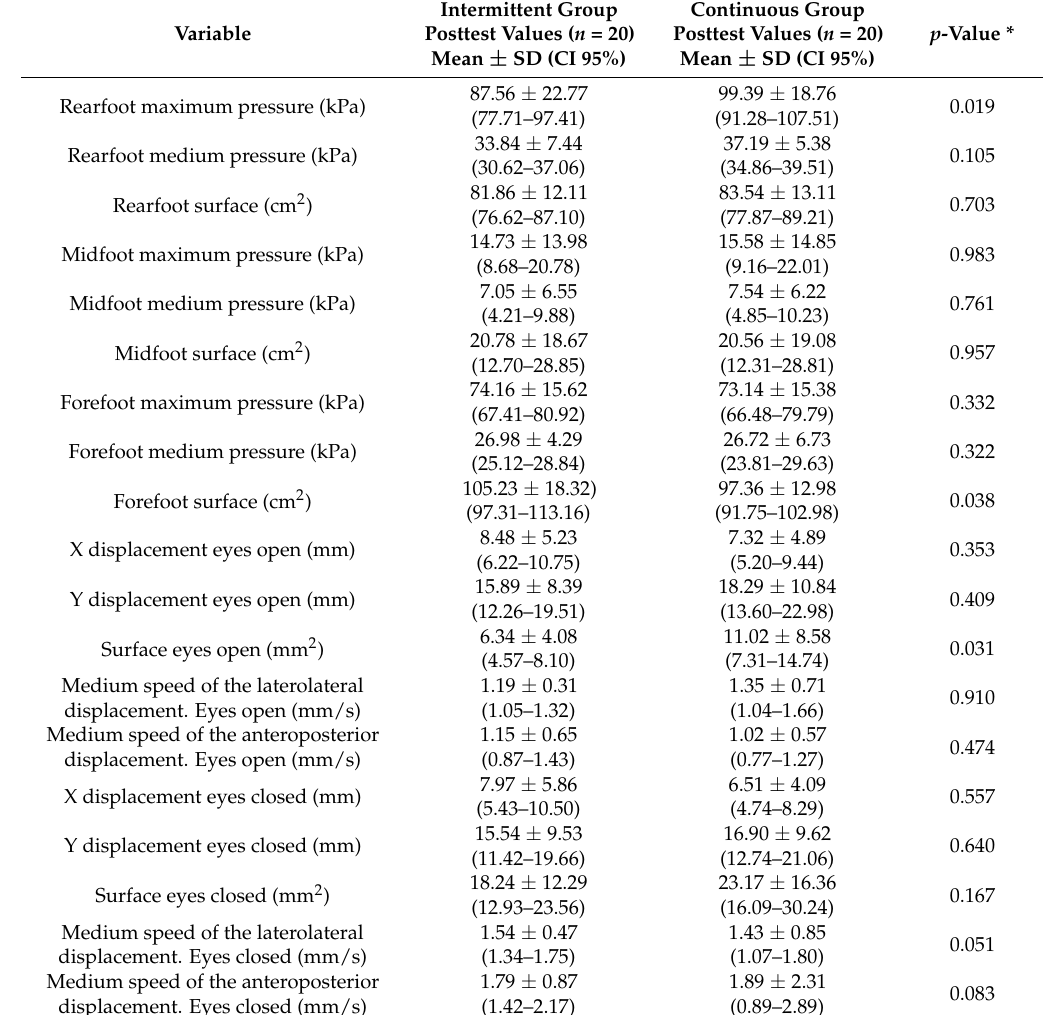
Table 4. Stabilometry and plantar pressure variables after bilateral intermittent and continuous